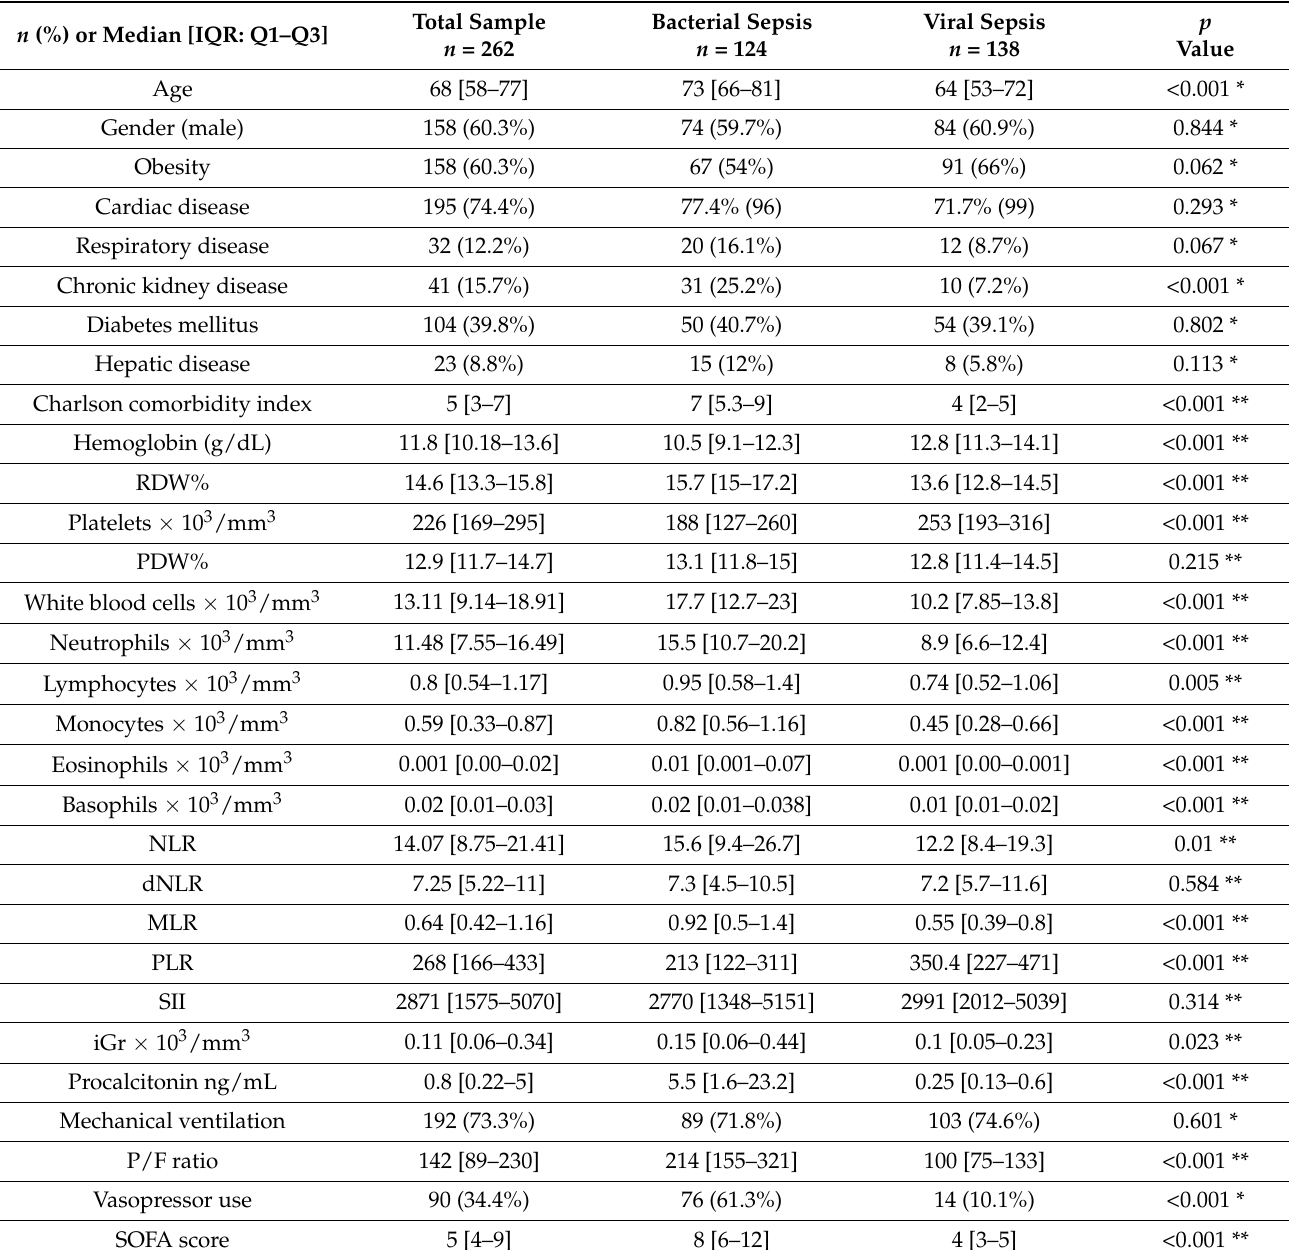
Table 1. Baseline Characteristics of the Study